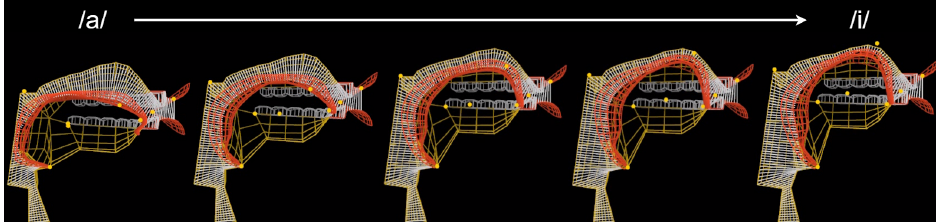
Figure 8. Manually controlled vocal tract while synthesizing/ai/sound.